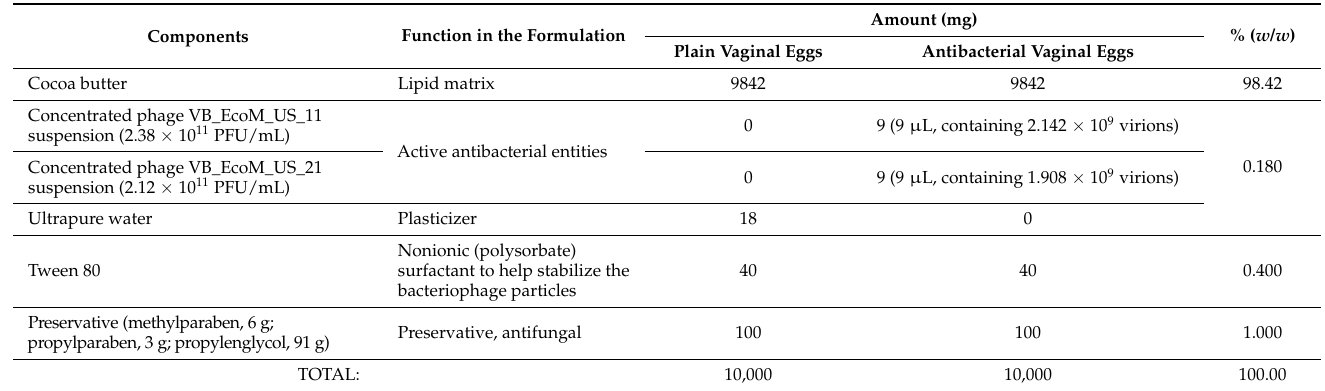
Table 2. Composition of the formulation utilized to prepare the vaginal eggs integrating a cocktail